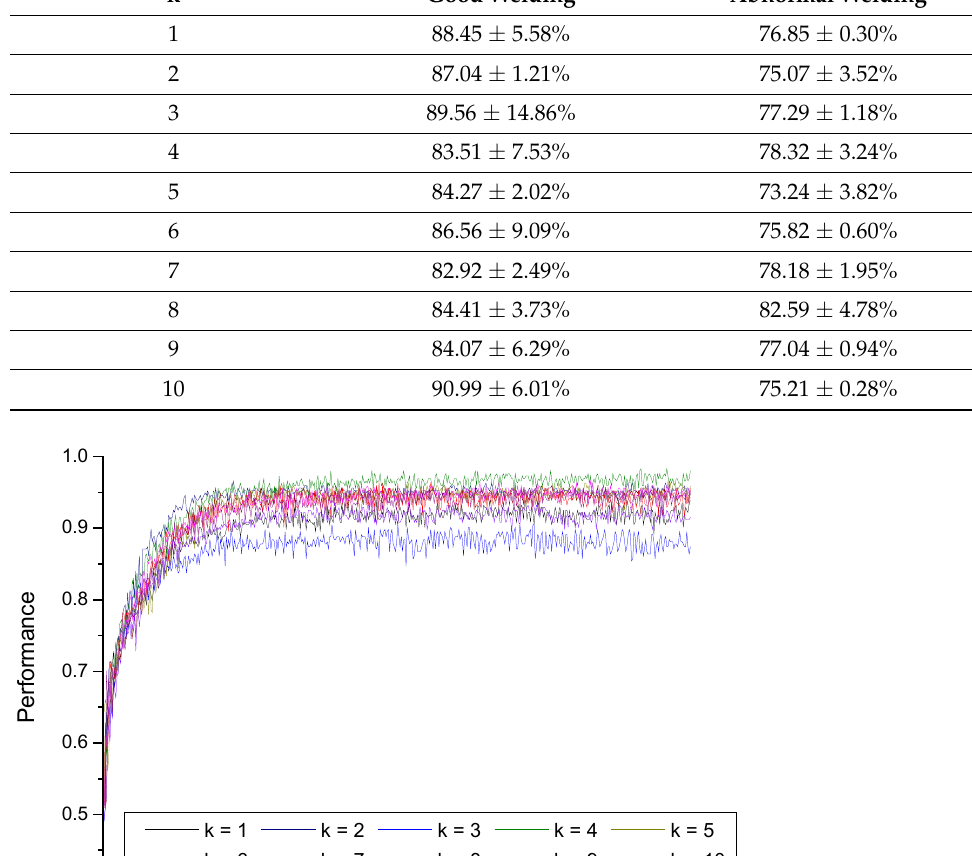
Table 1. Performance of the fully connected deep neural network .